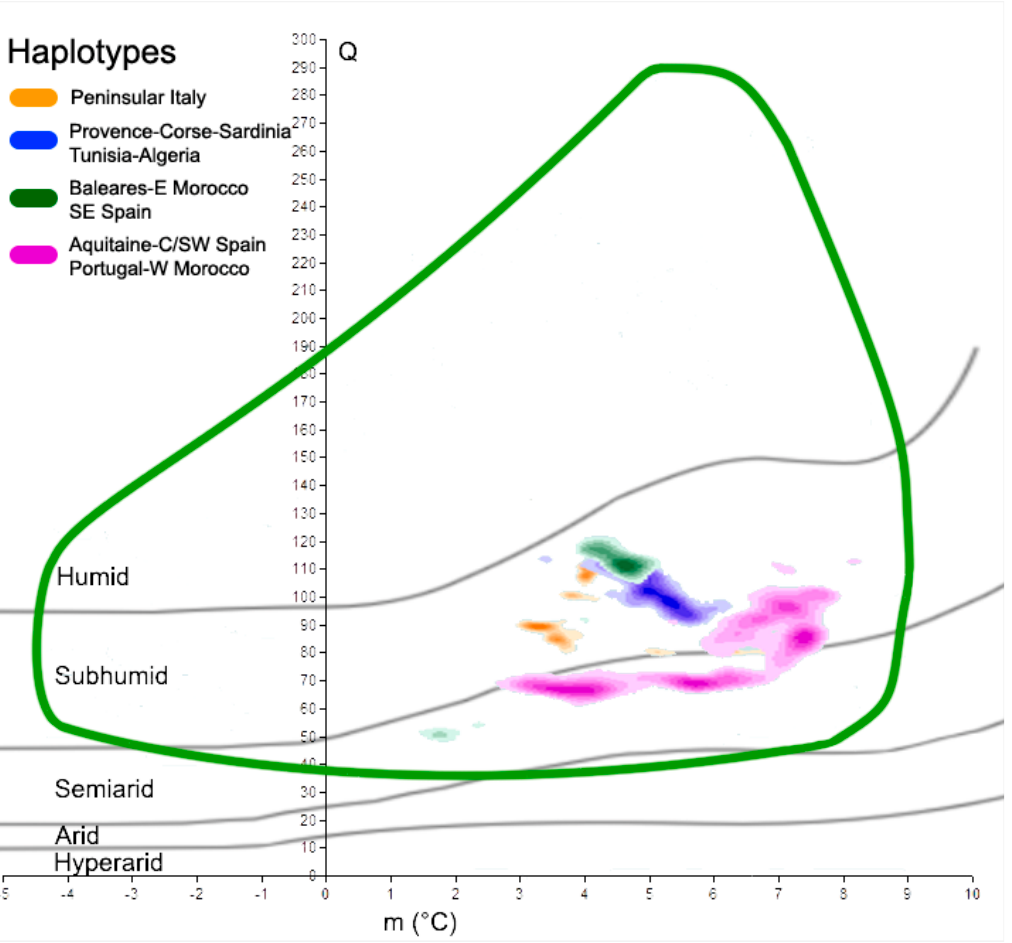
Figure 5. Selection and plot of the five highest density classes, at present, for each haplotype on Emberger’s diagram in comparison with cork oak climatogram (green curve). The darker the subtle color of each haplotype, the higher the density of real points at certain Q-m values. Table 2. Minimum, mean and maximum values of Q and m parameters for the haplotypes investigated in this study. Present, 2050 and 2070 time slices are reported for